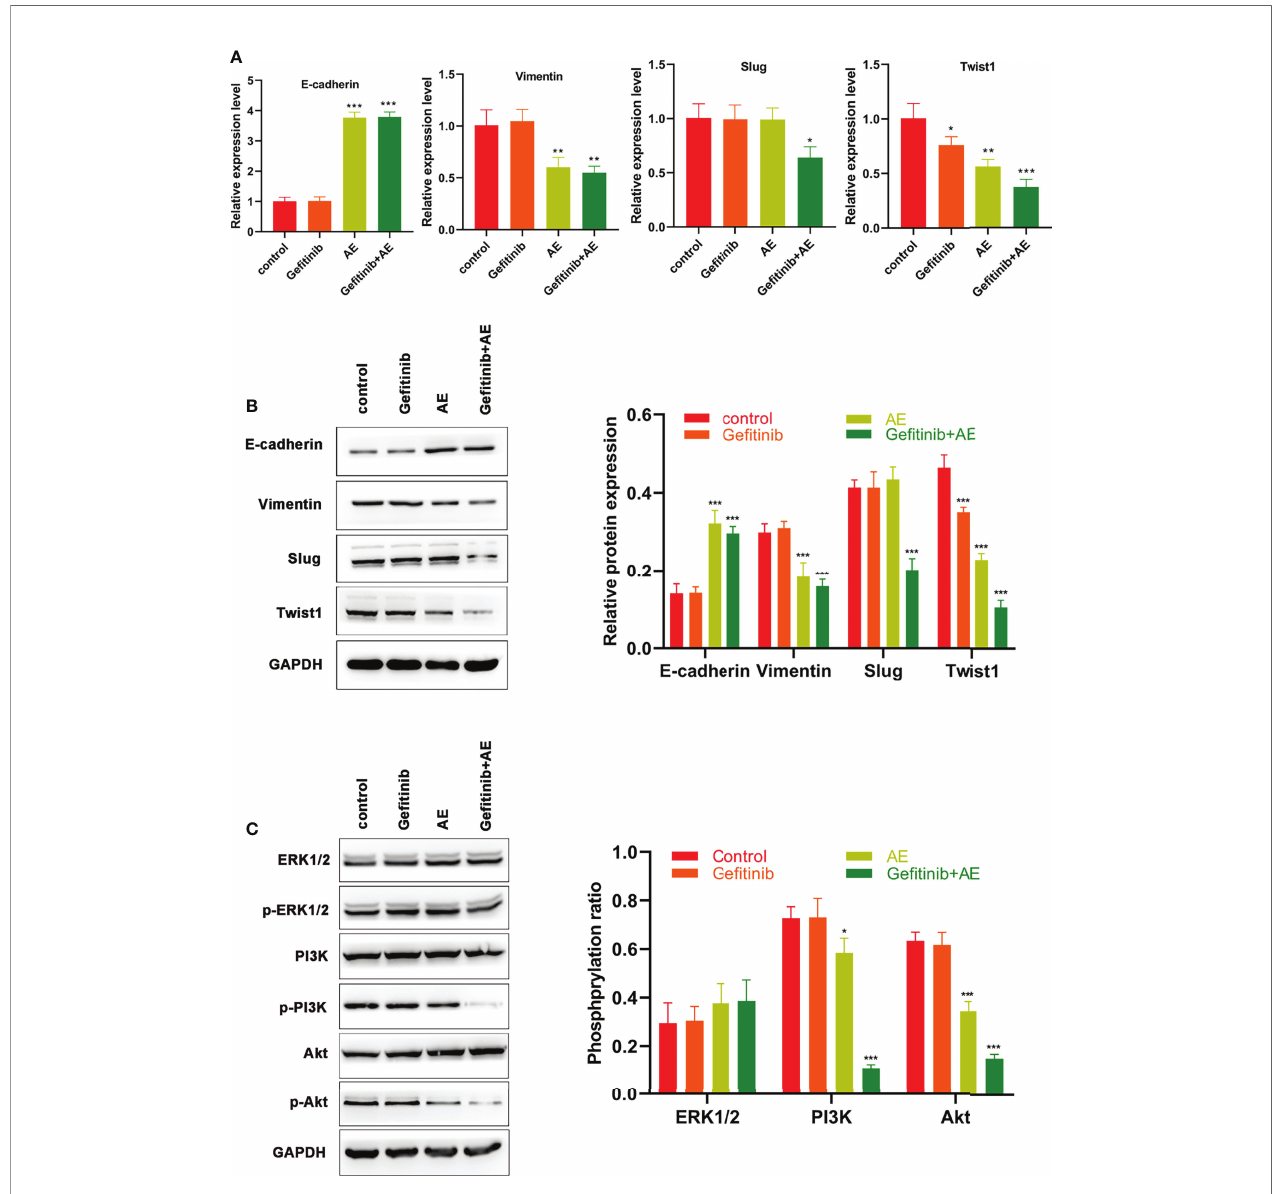
FIGURE 3 | AE Could Reverse EMT Induced by Drug Resistance in PC9-GR Cells. (A) qPCR results of E-cadherin, Vimentin, Slug and Twist1 for PC9-GR cells. (B) WB results of E-cadherin, Vimentin, Slug, and Twist 1 for PC9-GR cells (C) WB results of the PI3K/Akt pathway related proteins for PC9-GR cells. *p<0.05, **p<0.01,